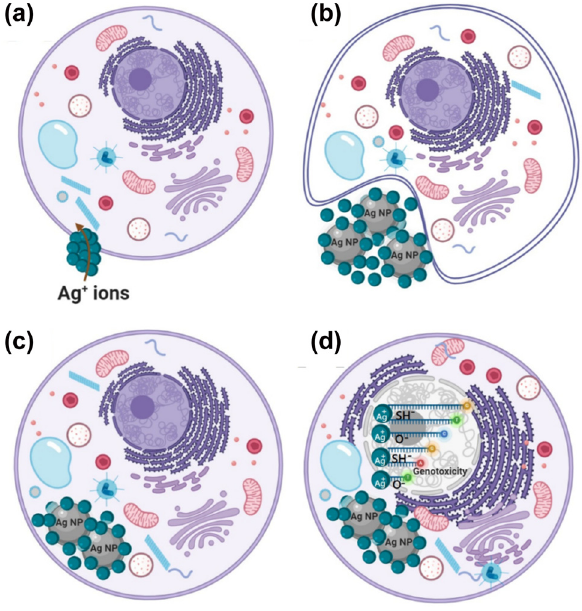
Figure 8: Toxicity of AgNPs and silver ions on the normal cells and Trojan horse e ff ect. ( a ) cell defense response to Ag + ( b ) engulf AgNPs and Ag + ions ( c ) excite of Ag ions inside cell and ( d ) death cell